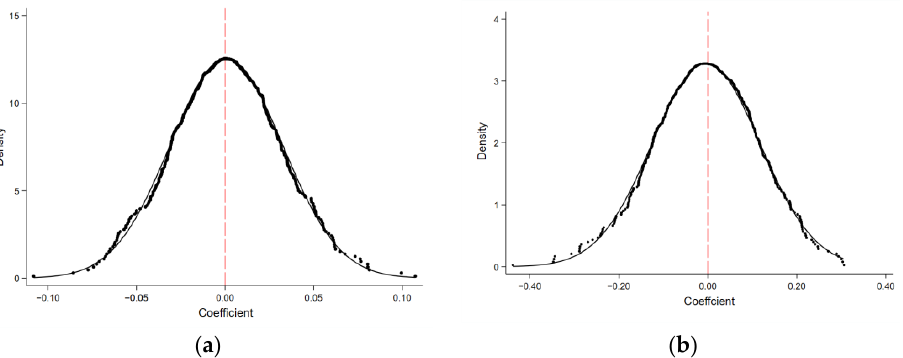
Figure 2. Placebo test. ( a ) economic growth. ( b ) environmental pollutant. Notes: the dotted line shows the cumulative distribution density of the coefficients is from 500 simulations randomly, and the solid line shows the normal distribution.